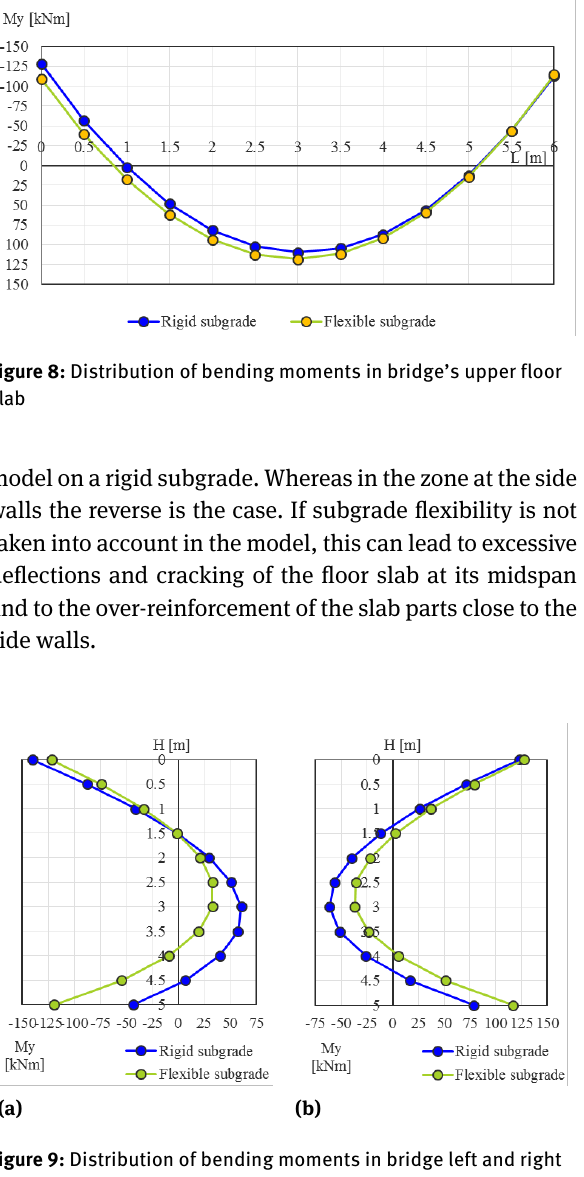
In the middle of the height of the bridge’s side walls the value of bending moment M y is lower in the model which takes subgrade elasticity into account than in the model on a rigid subgrade. The reverse is true for the lower wall zone at the bottom slab of the bridge, where the value of bending moment M y is higher in the model taking into account subgrade elasticity. If subgrade elasticity is not taken into account in the bridge model, this can lead to the cracking of the side walls in the zone at the bottom slab from the embankment side and to the-over reinforcement of the middle zone of the side walls.